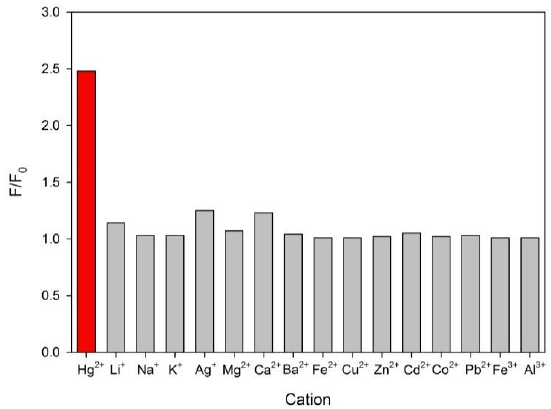
Figure 4. Bars representing the final (F) over the initial fluorescence emission of the probe (F 0 ) in the presence of 2.00 μg·L –1 of several cations.